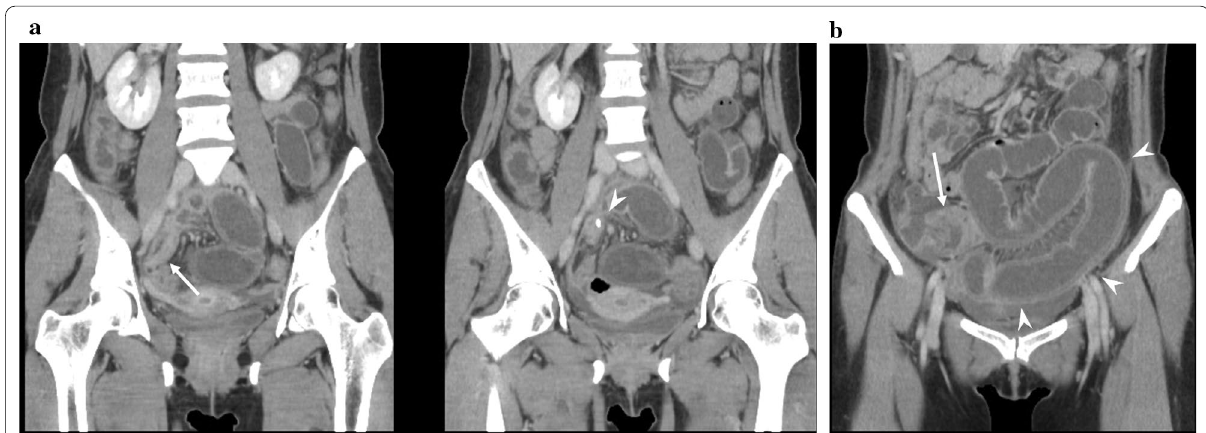
Fig. 1 Abdominal contrast-enhanced computed tomography findings. a An appendix wall (white arrow) was thickened and there was a fecalith (white arrowhead) at the appendix root. b The cecum (white arrow) was edematous, and the small intestine in the pelvis (white arrowhead) was dilated